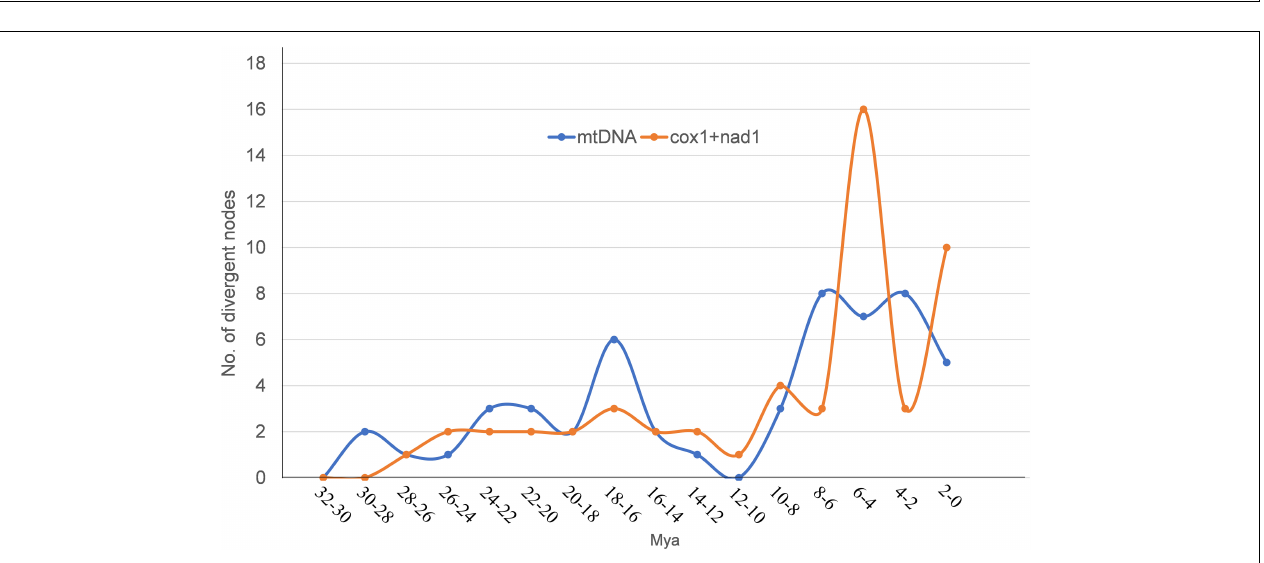
FIGURE 5 | The number of divergent nodes in every 2 Mya over time based on the divergence time trees of Figure 4 . The orange curve represents the change of divergence nodes number based on Figure 4A . The blue curve represents the change of divergence nodes number based on Figure 4B .